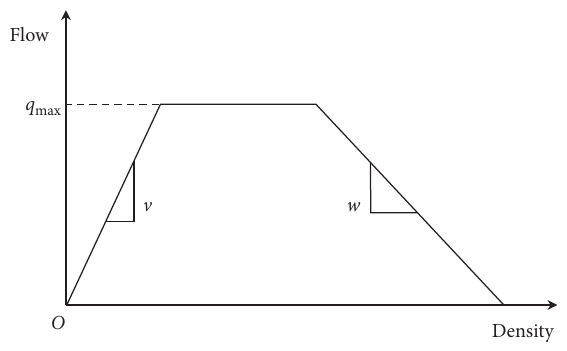
Figure 2: Basic flow-density relationship diagram of